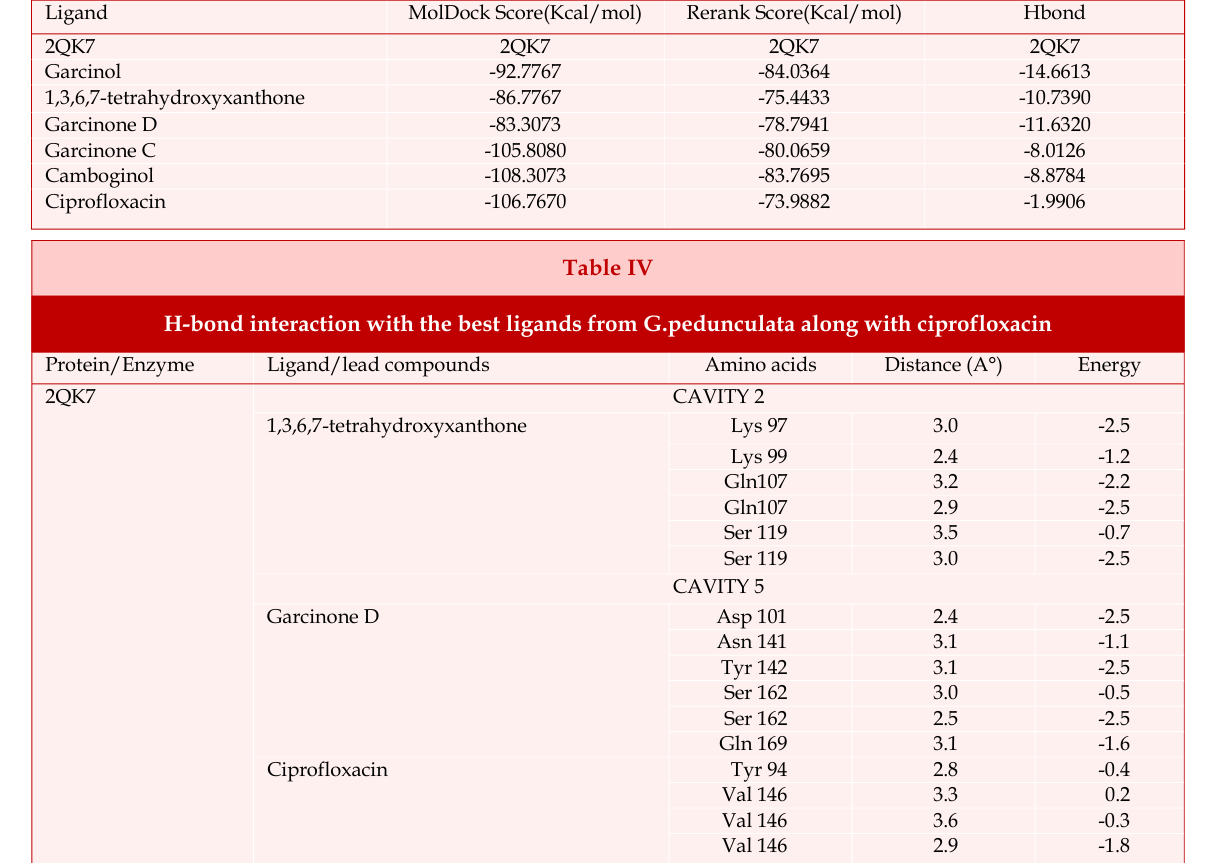
Energy score and H-bond interactions of the ligands with the target protein Chain A of 2QK7.pdb MolDock Score(Kcal/mol)